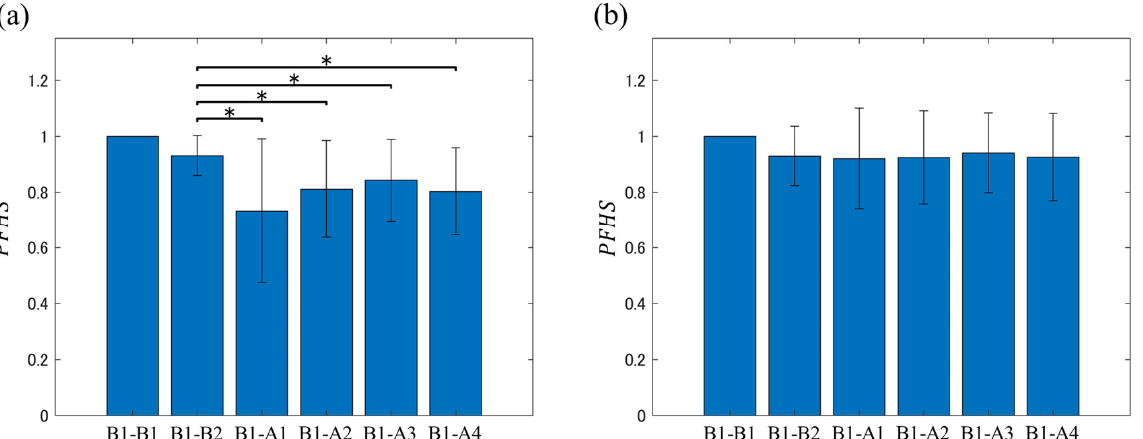
Figure 6. Comparison of results obtained with the  of B1-A1, B1-A2, B1-A3, and B1-A4 from ( a ) carbonated water intake and ( b ) cold water intake (  of B1-B2 was set as a reference). * Significant difference at p <